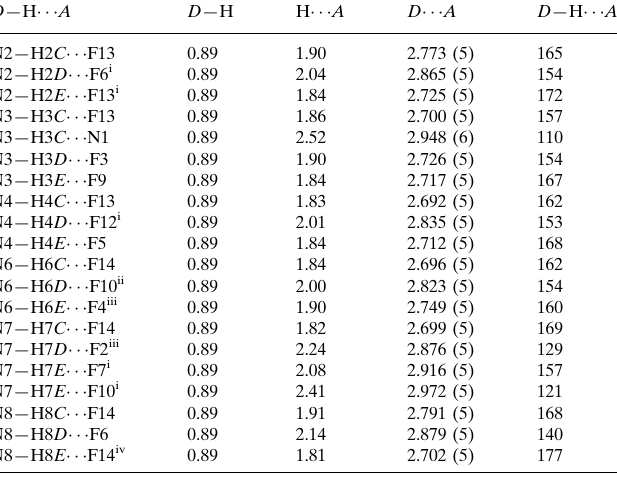
Hydrogen-bond geometry (A˚ , (cid:3)